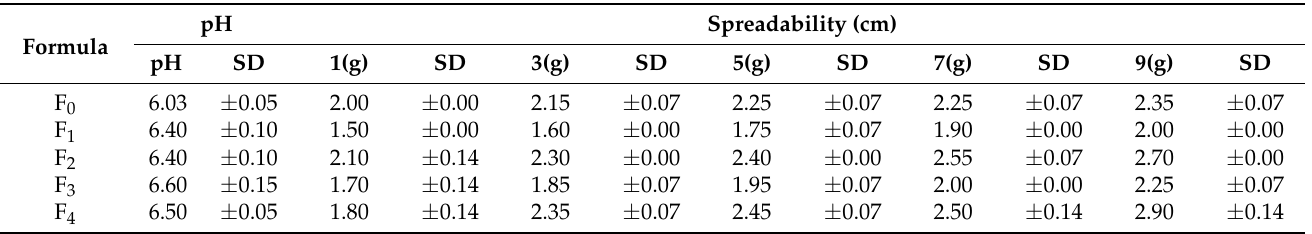
Table 7. Average pH test and spreadability of polyvinyl alcohol/corn starch/patchouli oil/hydrogel films loaded with silver nanoparticles.